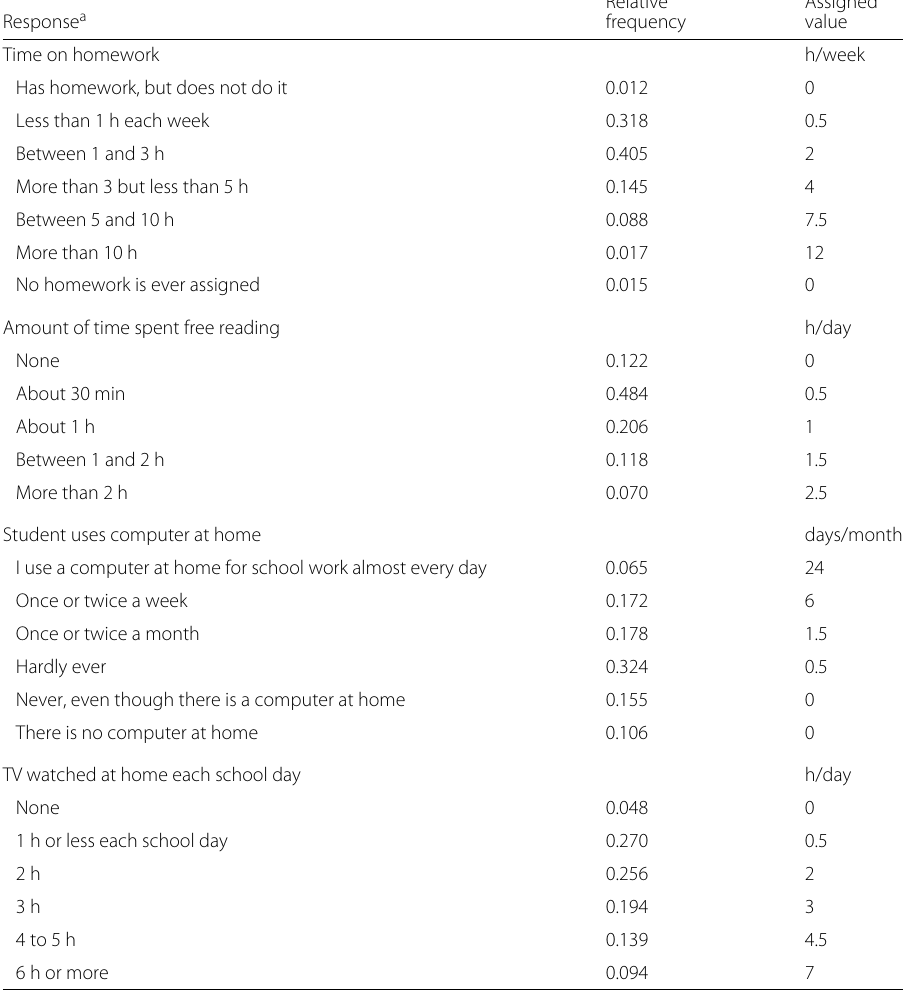
Table 6 Conversion of time use categories to continuous